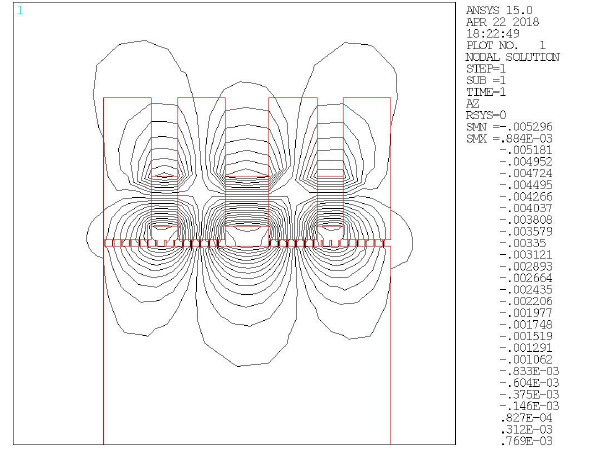
Fig. 10 The distribution of magnetic field lines using magnetic sealant to bond the split pole shoes.